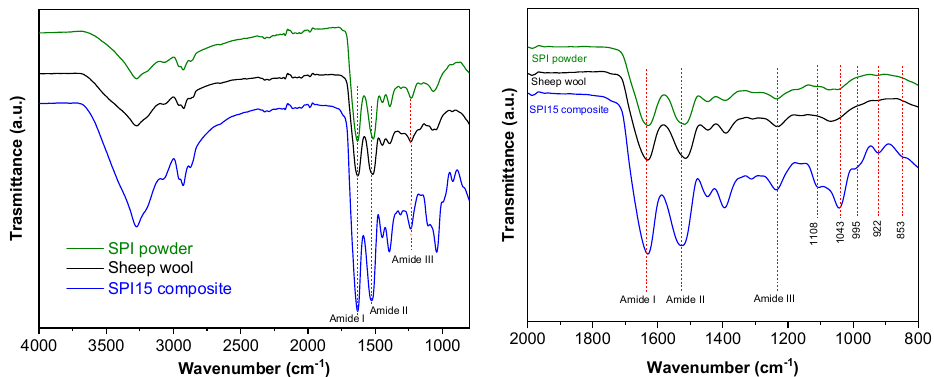
Figure 7. FTIR spectra of neat SPI, neat wool, and SPI15 biocomposite from ( a ) 4000 to 800 cm −1 and ( b ) from 2000 to 800 cm −1 .